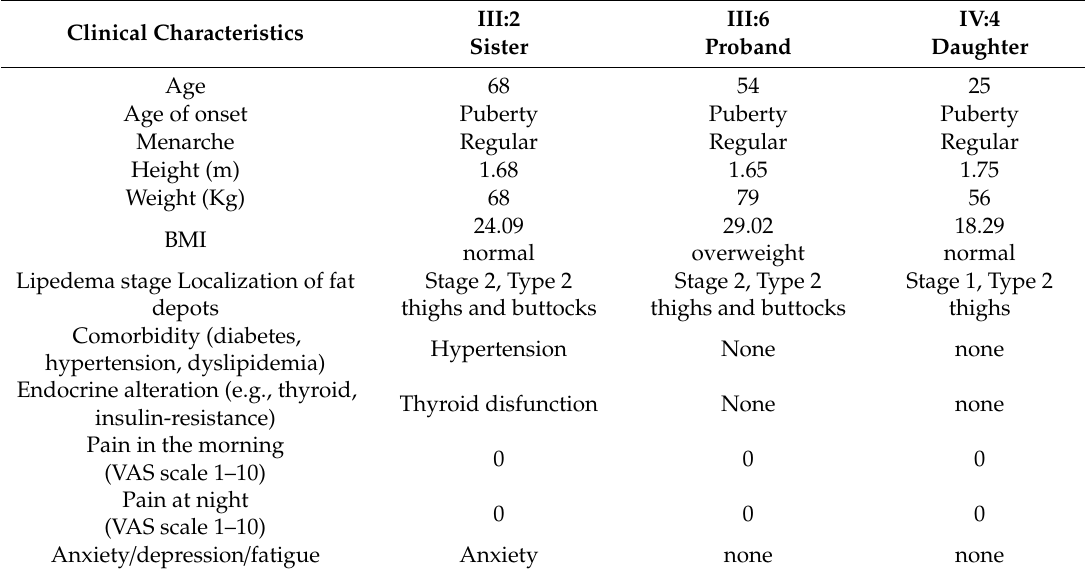
Table 3. Clinical characteristics of the proband and her